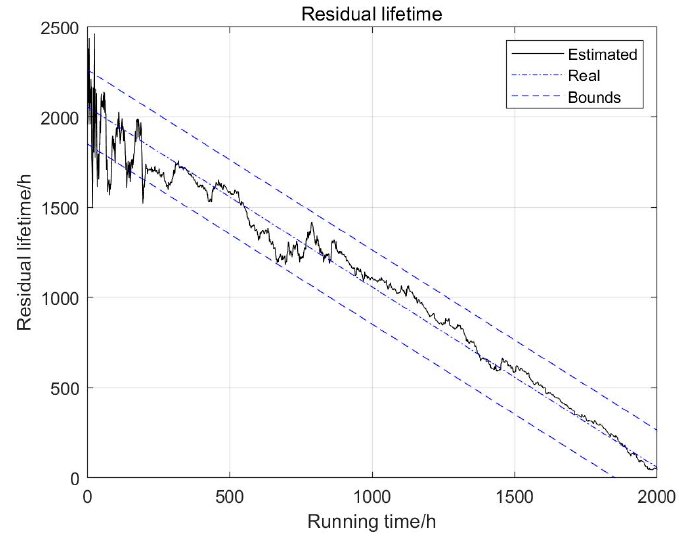
Figure 9. Residual lifetime simulation results.